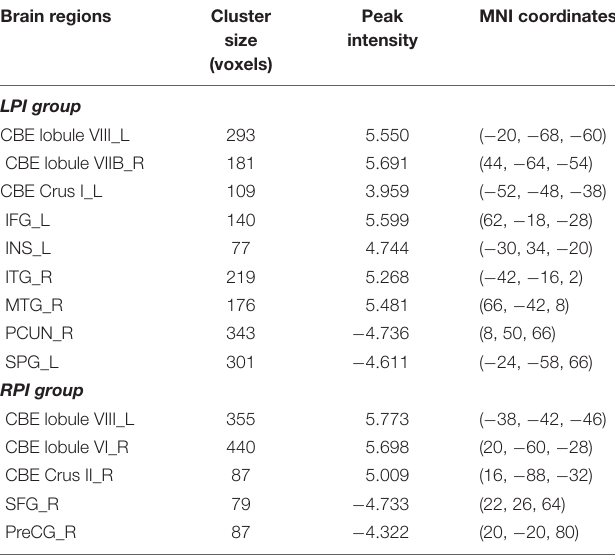
TABLE 2 | Brain regions with different CBF between the baseline stage of PI and NC